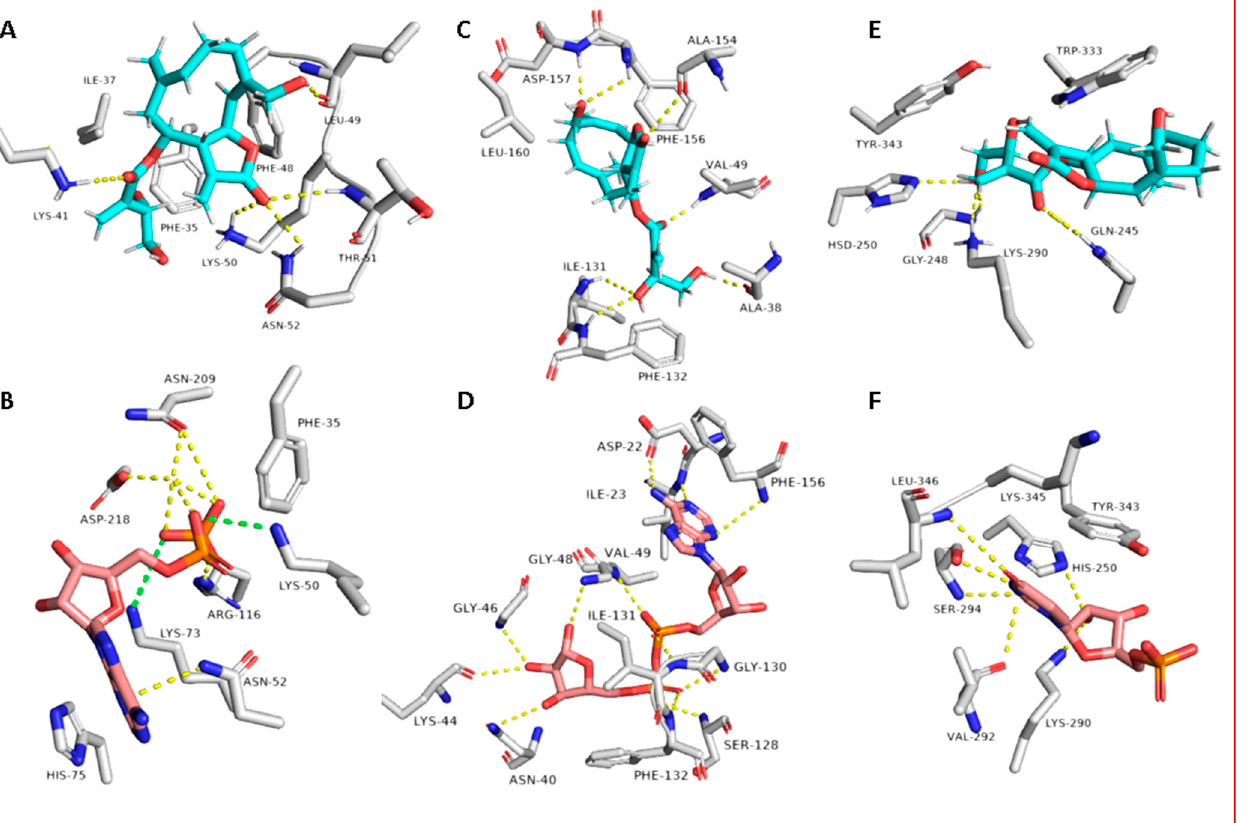
Figure 8. Binding modes of cnicin inside the binding sites of SARS CoV-2 nsp12, nsp3, and nsp15 ( A , C , and E , respectively) during 100 ns of MDS (i.e., the last snapshots of the simulations), along with the binding modes of the corresponding co-crystallized ligands ( B , D , and F , respectively).